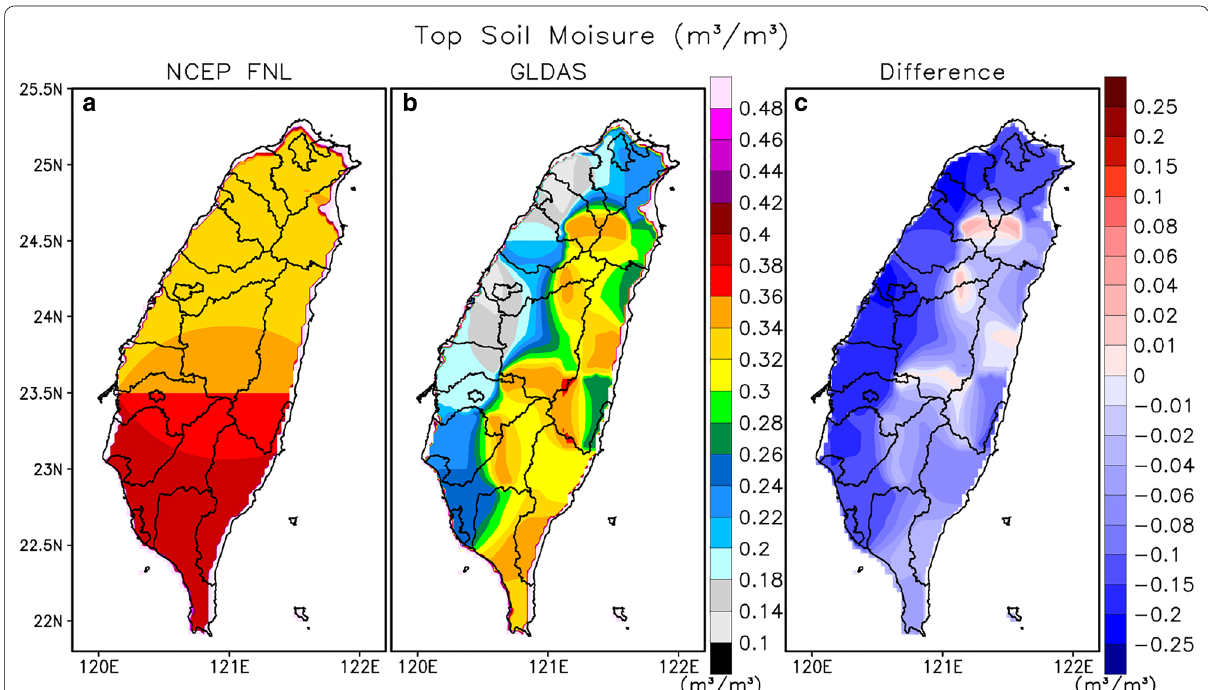
Fig. 4 Top‑layer (0–10 cm) soil moisture at 0000 UTC 1 Oct 2014 from a NCEP FNL, b GLDAS, and c corresponding